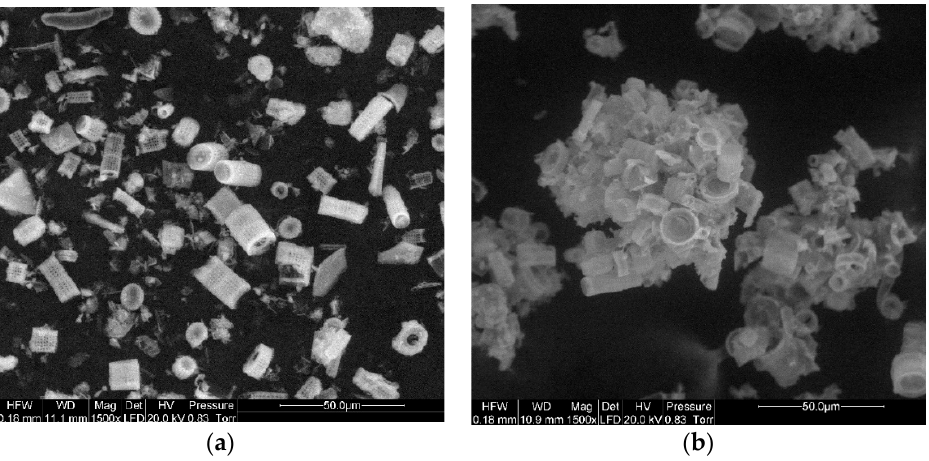
Figure 1. Images of the microstructure of diatoms from diatomaceous earth containing silica ( a ) in amorphous form and ( b ) from diatomaceous earth, with a high content of crystalline silicon. (Own research, images were taken with a scanning electron microscope Quanta 200 XL, FEI, Oregon, USA).